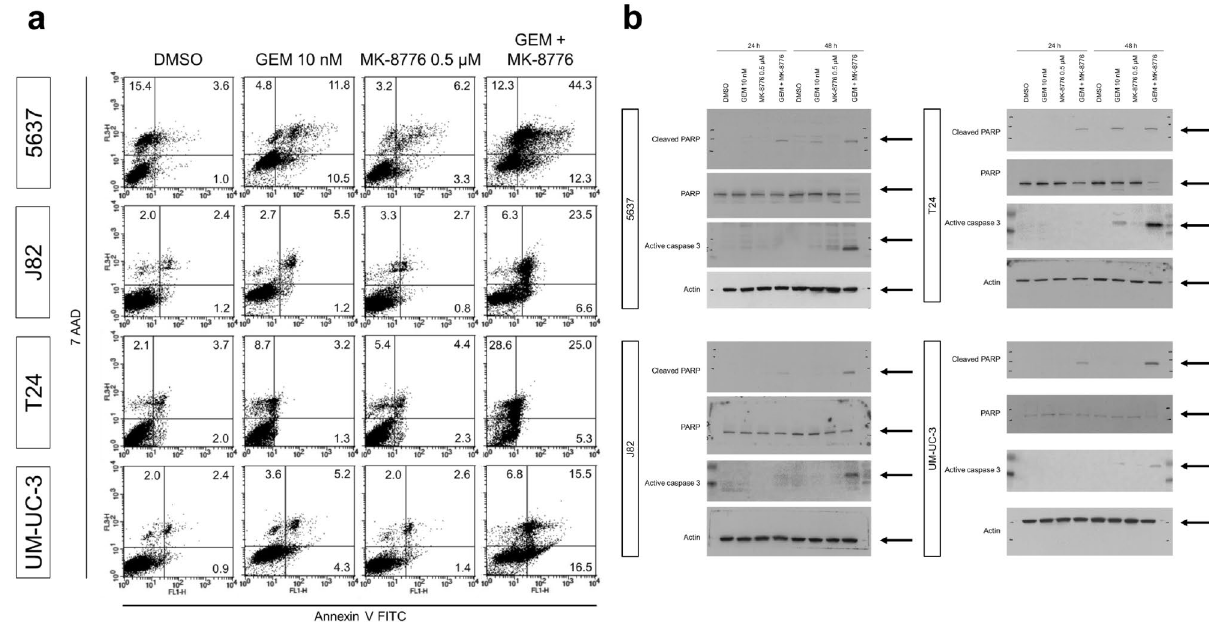
Figure 3. Cell death mechanism induced by the treatments. ( a ) Flow cytometric analysis of bladder cancer cells treated with indicated conditions after combined staining with Annexin V and 7-AAD. The results are expressed as a percentage of early apoptotic cells (lower right quadrant), late apoptotic cells (upper right quadrant) and necrotic cells (upper left quadrant). ( b) PARP cleavage 48 h after the indicated treatments were assessed by western blotting. Actin was used as a loading control. A quantification of the signals is illustrated in Fig. S5.